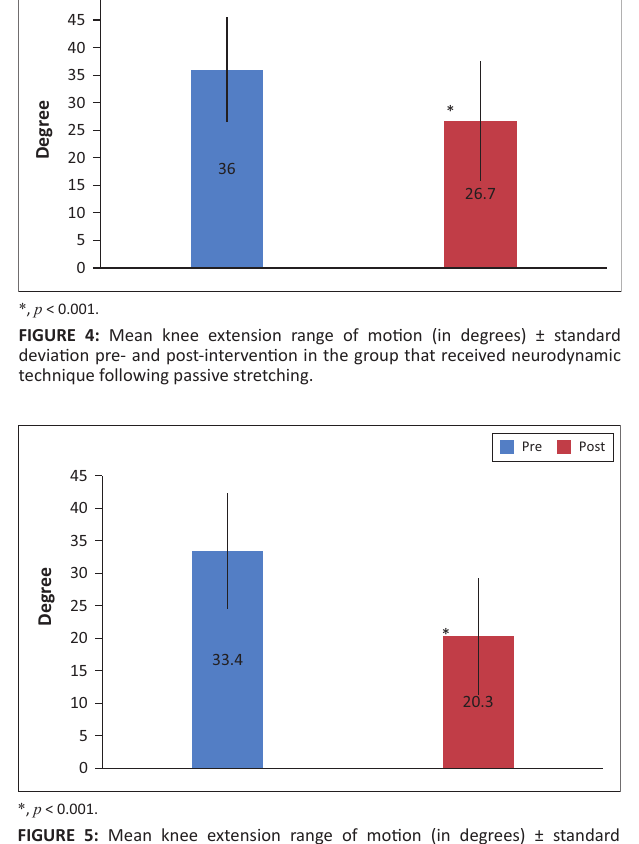
FIGURE 5: Mean knee extension range of motion (in degrees) ± standard deviation pre- and post-intervention in the group that received quadriceps activation following passive